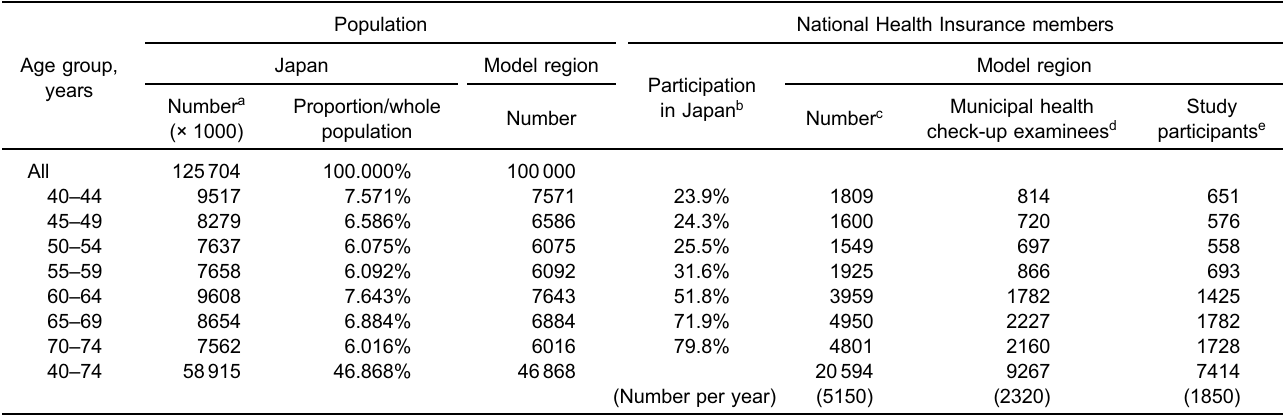
Table 1. Estimation of populations, National Health Insurance members, special health check-up examinees, and study participants in a model region by age group